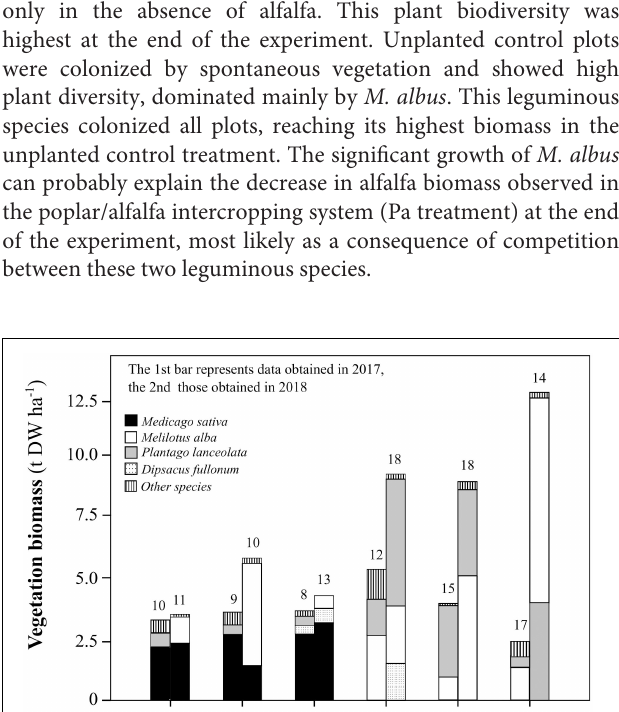
FIGURE 1 | Biomass of herbaceous vegetation. Treatments: a, planting of alfalfa; Pa, intercropping of non-mycorrhizal poplars with alfalfa; Pia, intercropping of mycorrhizal poplars with alfalfa; Pv, planting of non-mycorrhizal poplars with spontaneous vegetation; Piv, planting of mycorrhizal poplars with spontaneous vegetation; and v, spontaneous vegetation (unplanted control). Each stacked bar represents the total biomass of all the species found in each treatment. Different colors represent the biomass of the most abundant plant species. Numbers above bars indicate the total number of species found in each treatment.